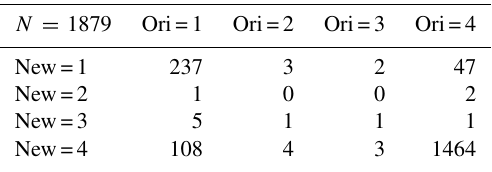
Figure 13. Fragment of the MISR browse product for Path 168, Orbit 92981, Blocks 101 to 108, camera AN. The various Blocks in this scene, which covers central south Malawi and northwest Mozambique, exhibit varying levels of cloudiness. See text for de- tails. Table 3. Confusion matrix for P168, O092981, B101, camera CA.